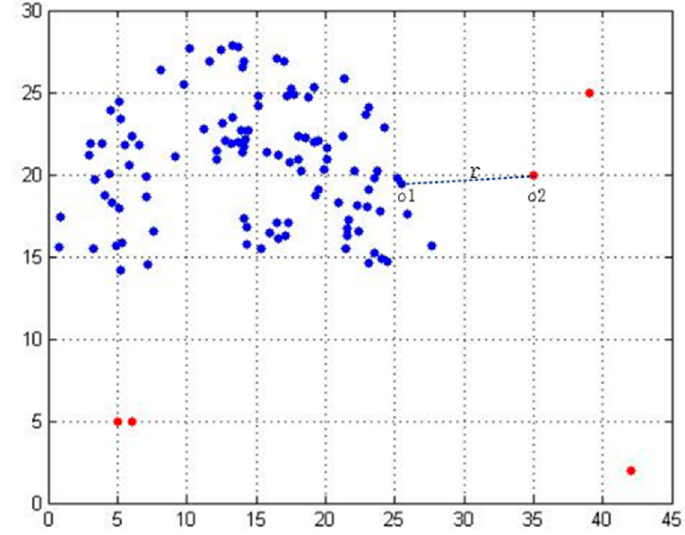
Figure 5. The effects of parameter selection in outlier detection algorithms (normal points in blue (o1), outliers point in red (o2)).